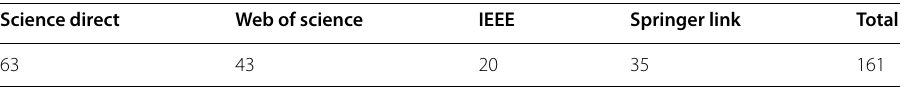
Table 6 Quality examination stage